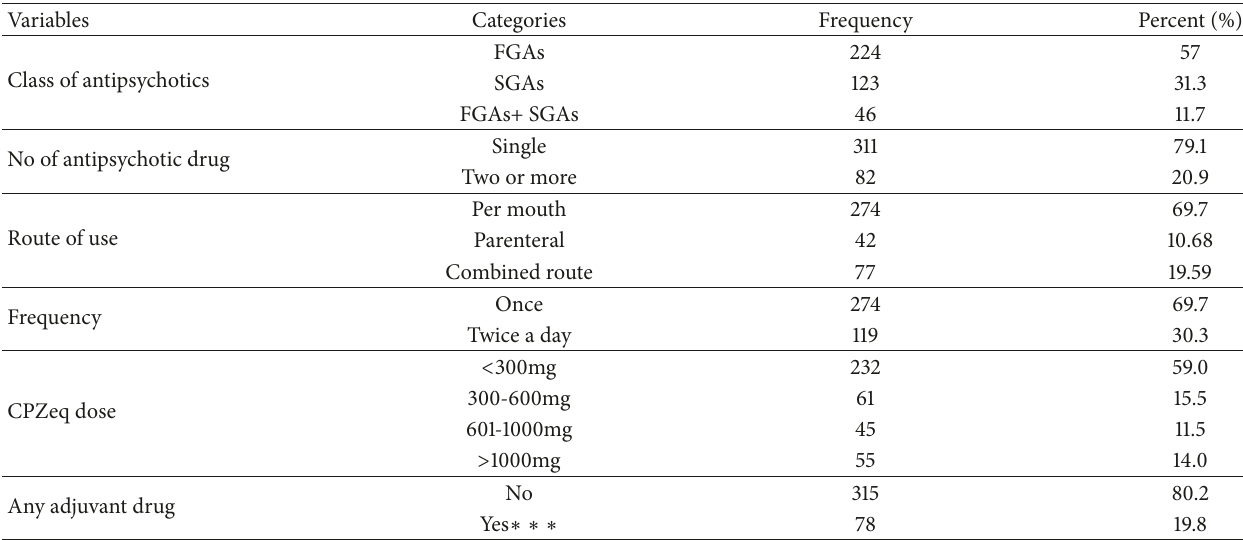
Table 3: Drug therapy related characteristics among patients with schizophrenia on follow-up at AMSH, 2018 (n= 393).